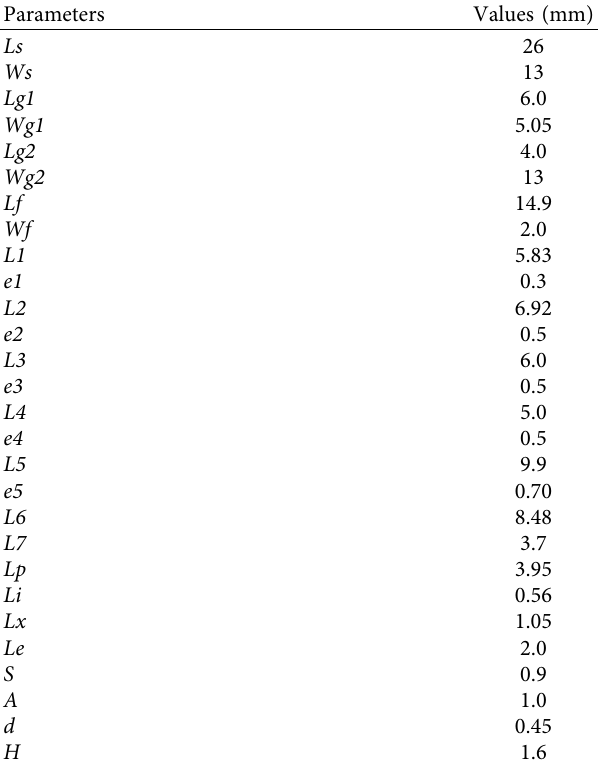
Table 1: Parameters of the proposed